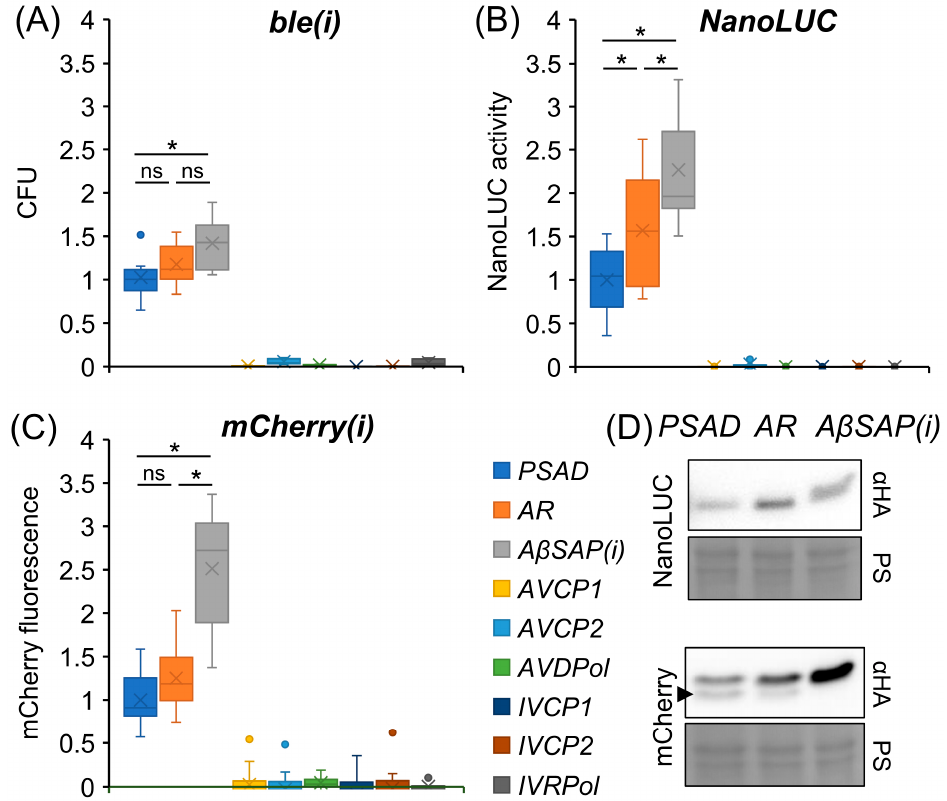
Figure 2. Quantification of viral promoter strength compared to benchmark promoter strength using ble(i) , NanoLUC and mCherry(i) reporters. ( A ) Number of zeocin-resistant colony-forming units (CFU) normalized to CFUs obtained with the PSAD-ble(i) reporter (set to 1). After transformation and plating on agar plates containing 2 µ g/mL zeocin, CFUs were counted after eight days ( n = 6). ( B ) Bioluminescence signals from NanoLUC measured in transformant pools normalized to signals obtained for pools generated with the PSAD-NanoLUC reporter construct ( n ≥ 6). ( C ) mCherry fluorescence measured in transformant pools normalized to pools generated with the PSAD-mCherry(i) reporter ( n ≥ 9). ( D ) Comparison of NanoLUC and mCherry protein accumulation in transformant pools. Total cell proteins corresponding to 1 µ g chlorophyll were separated by SDS-PAGE and analyzed by immunoblotting using an HA antibody. Ponceau S (PS) staining shows equal loading. The arrowhead points to a shorter mCherry variant. To test for significant differences between AR - and A β SAP(i)- versus PSAD promoter-driven reporters, a one-factor ANOVA was performed using Bonferroni’s multiple comparison test (*: p < 0.05; ns: not significant). There were no significant differences between the viral promoters. Dots outside the whiskers represent